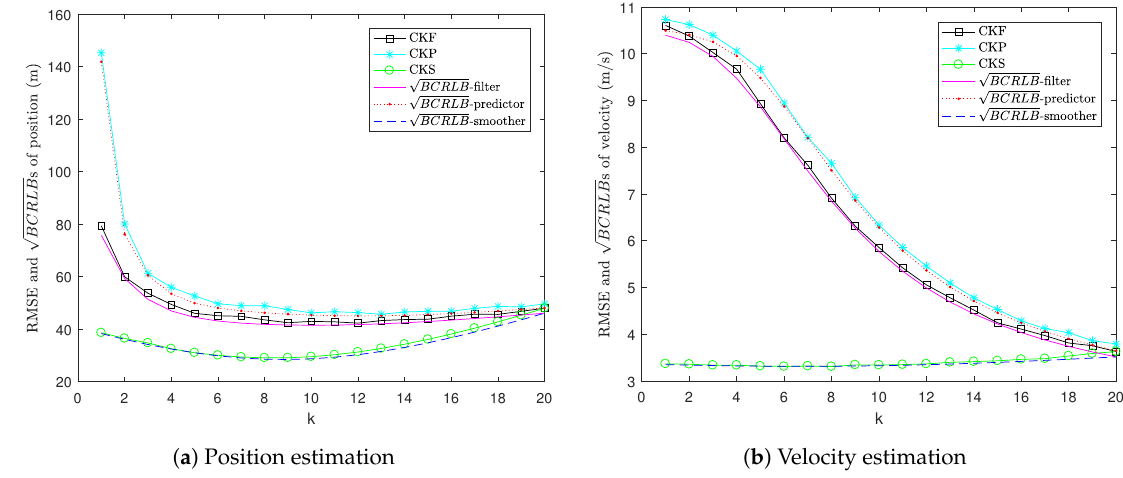
√ BCRLB in Example 1.